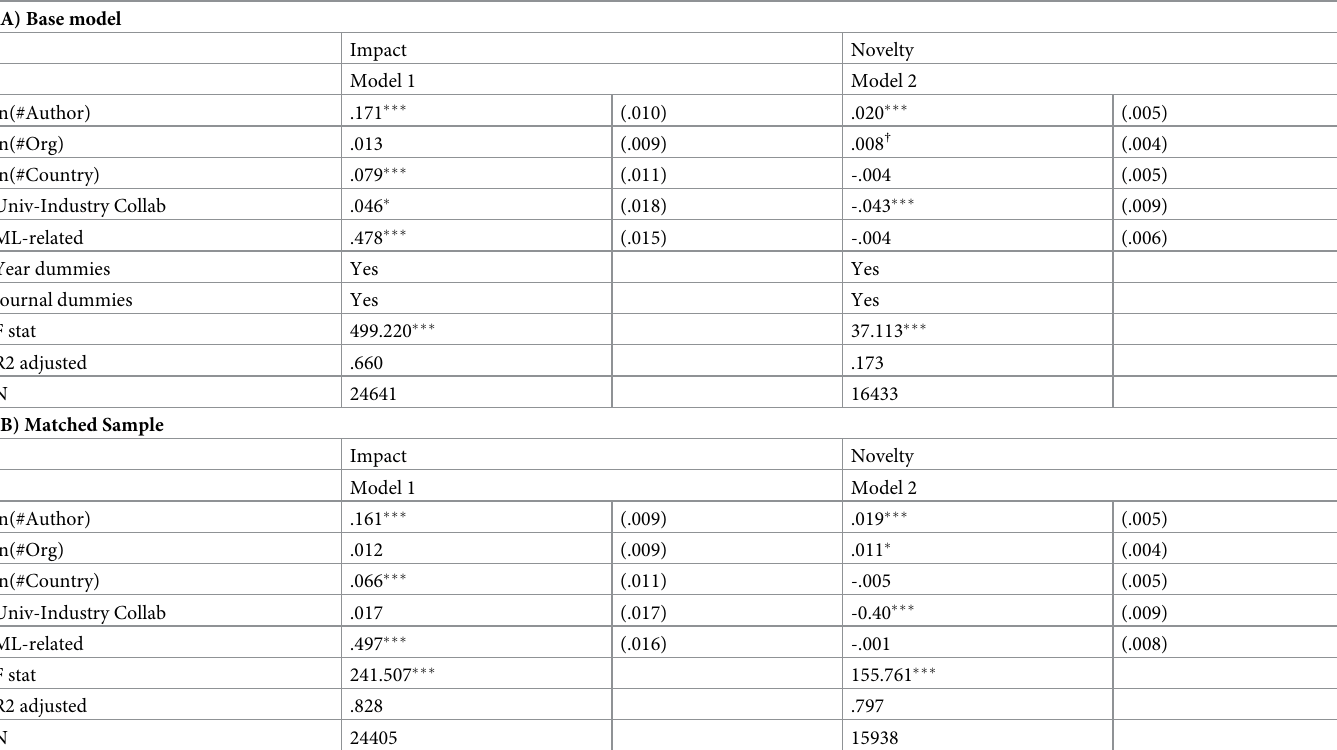
Table 2. Prediction of publication quality: ML-related vs. ML-unrelated